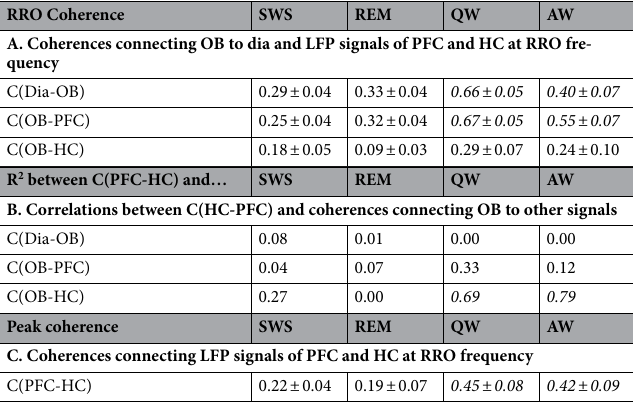
RRO Coherence SWS REM